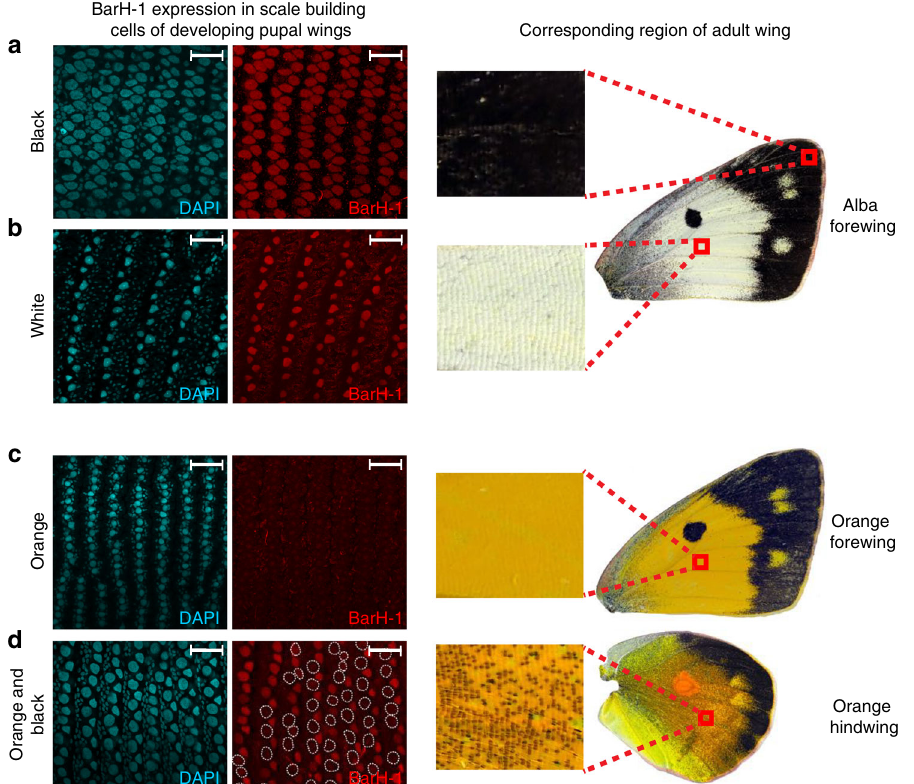
Fig. 2 BarH-1 is expressed in white but not orange regions of the wing in C. crocea . DAPI (nuclei, left, blue) and BarH-1 antibody (right, red) staining of pupal wings. Large nuclei are in scale building cells, small nuclei are in epithelial cells. The right part of the panel shows the approximate location of the stained area and the scales in this region in an adult female wing. Scale bars are 40 μ M. a Staining of the forewing of an Alba female from black and b white regions. BarH-1 is expressed in black (melanic) as well as white Alba scale building cells. c Antibody staining of the forewing of an orange female in orange region. BarH-1 is not expressed in the orange scale building cells. d Antibody staining of the hindwing of an orange female. BarH-1 is heterogeneously expressed in the scale building cells within this region. This staining pattern presumably corresponds to the variation in scale color, with melanic (black) scale building cells expressing BarH-1 but orange lacking